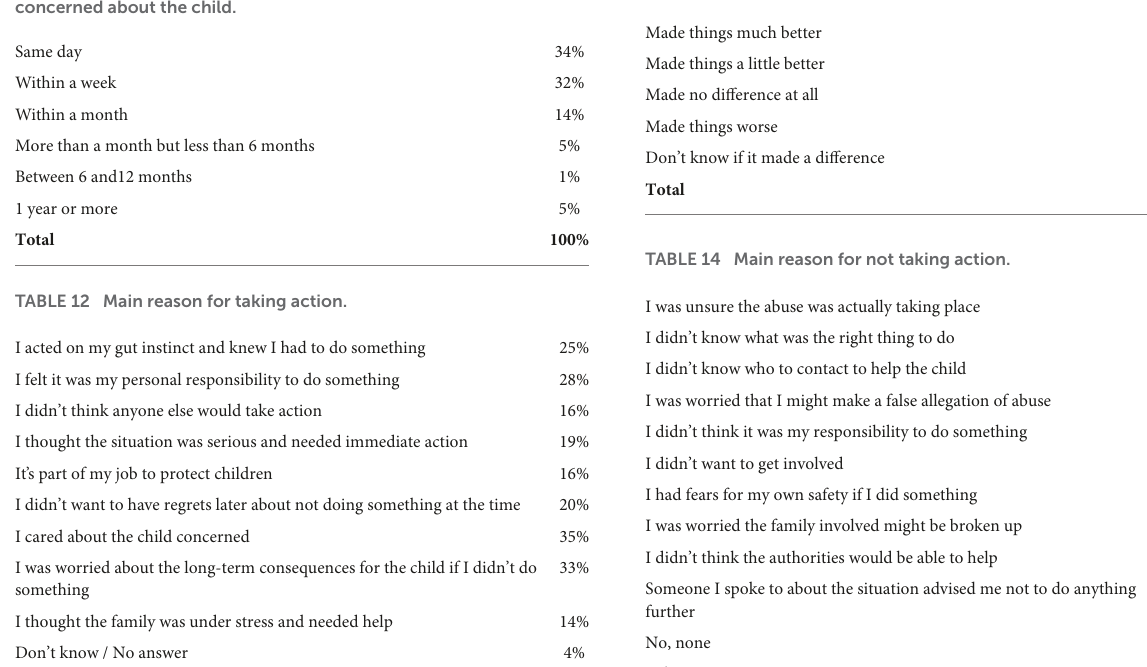
TABLE 13 Outcomes of action taken by respondents.